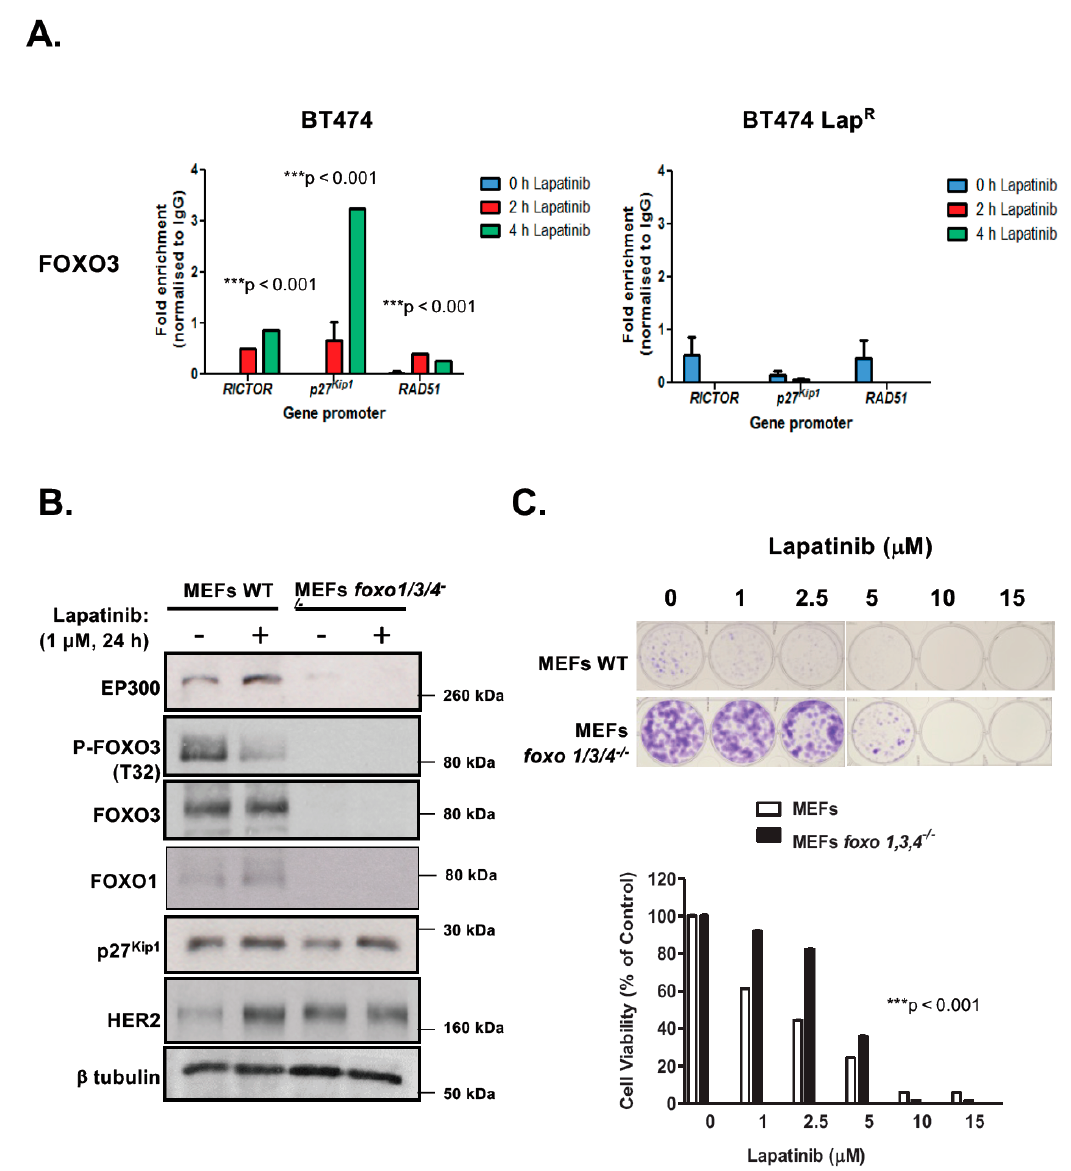
Figure 2. FOXO3 regulates lapatinib sensitivity in BT4T4 and MEFs. ( A ) Lapatinib induces Figure 3. recruitment to its target gene promoters in BT474 cells. Sensitive (WT) and drug resistant BT474 Lap R cells were harvested following treatment with 1 µM lapatinib for 0, 2 or 4 h. FOXO3 binding to the gene promoters of RICTOR , p27 Kip1 and RAD51 was then assessed by Chromatin immunoprecipitation (ChIP) analysis using anti-FOXO3 antibody. After crosslink reversal, immunoprecipitated DNA was amplified by qPCR using primers for each gene promoter indicated. Data were analyzed using the fold enrichment method and bars represent the means ± SEM of three independent experiments ( n = 3). The kinetics of FOXO3-binding were analyzed by two-way ANOVA and found to be significantly di ff erent between BT474 and BT474 Lap R cells (*** p < 0.001, for all genes, respectively). ( B , C ) FOXO3 regulates lapatinib sensitivity in MEFs. ( B ) Western blot analysis was performed to analyze the protein levels of EP300, FOXO3, FOXM1 and others indicated in MEFs and Foxo1,3,4 − / − MEFs. Representative western blots are shown. ( C ) Wild-type MEFs and Foxo1,3,4 − / − MEFs were treated with increasing doses of lapatinib and their sensitivity to lapatinib was assessed by clonogenic assay. Their clonogenicity in response to lapatinib was analyzed by two-way ANOVA and found to be significantly di ff erent (*** p < 0.001) from one